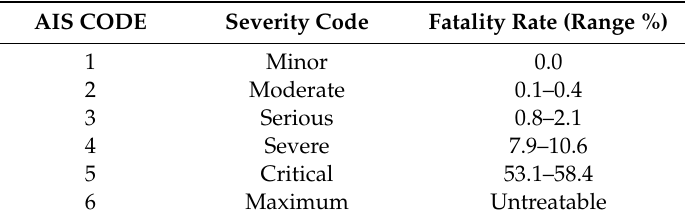
Table 5. Explanation of severity code by Hayes et al.